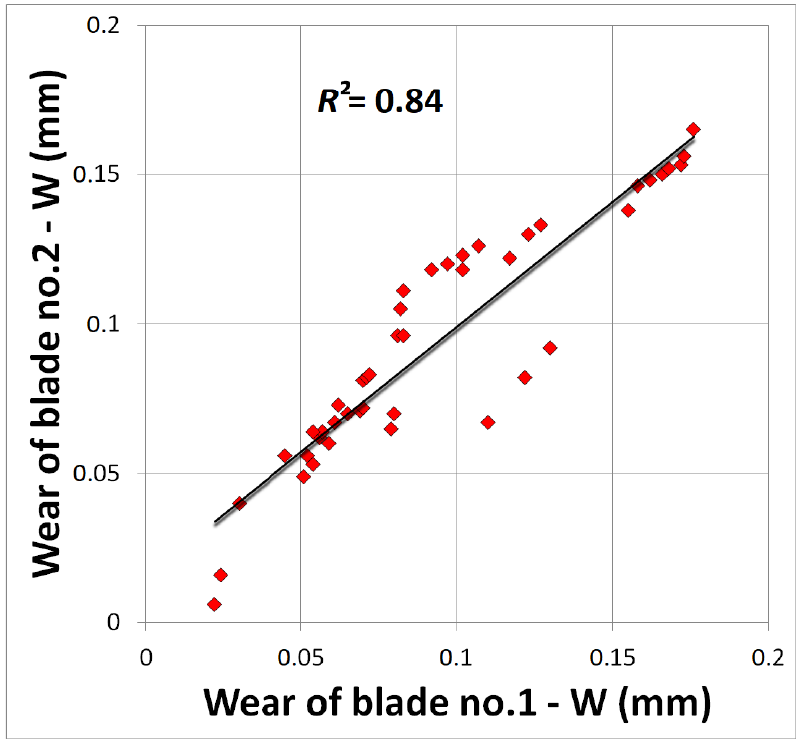
Figure 12. The correlation between the wear of two blades used in the same drill for tools belonging to Group A (control group containing four two-blade tools that were unmodified).